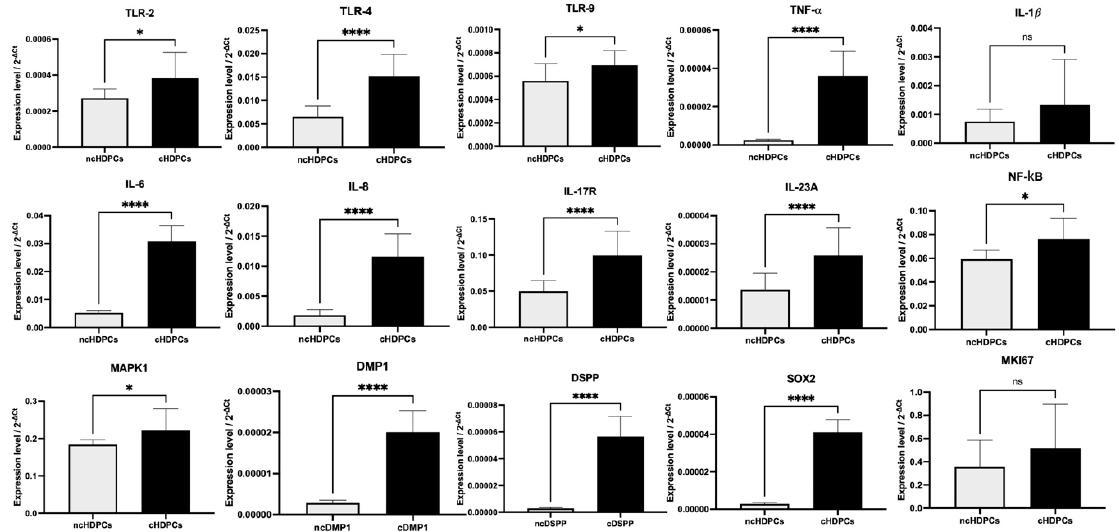
Figure 4. Gene expression assay by quantitative real-time PCR analysis for markers relating to inflammation (TLR2, TLR4, TLR9, TNF- α , IL-6, IL-8, IL-17R, IL-23A, NF- κ B, MAPK1), dentinogenesis (DMP1, DSPP), pluripotency (SOX2) and proliferation (Ki67) in cultures at passage 4 (n = 5 each). Values are presented after normalization to average of GAPDH and ACTR1B levels. * Indicates * p < 0.05, **** p <0.0001, ns = non-significant. Error bars indicate mean ± SD.